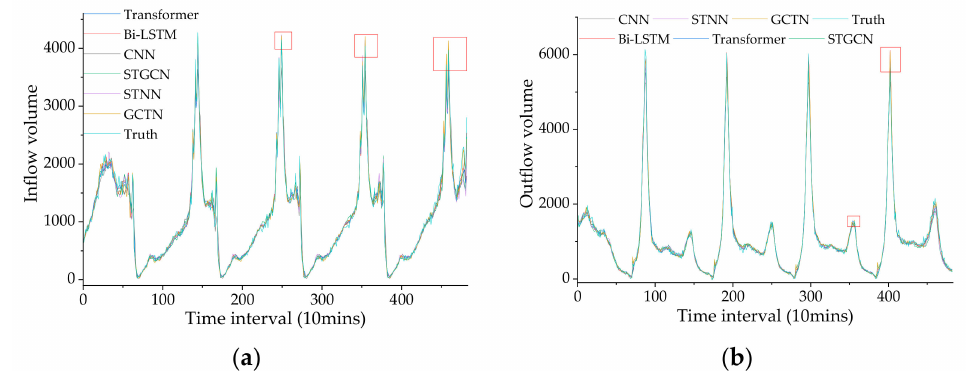
Figure 11. The prediction of passenger flow in the People’s Square Station, ( a ) Inflow volume; ( b ) Outflow volume. The time interval is 10 min and the test period covers a half non-working day and four working days.